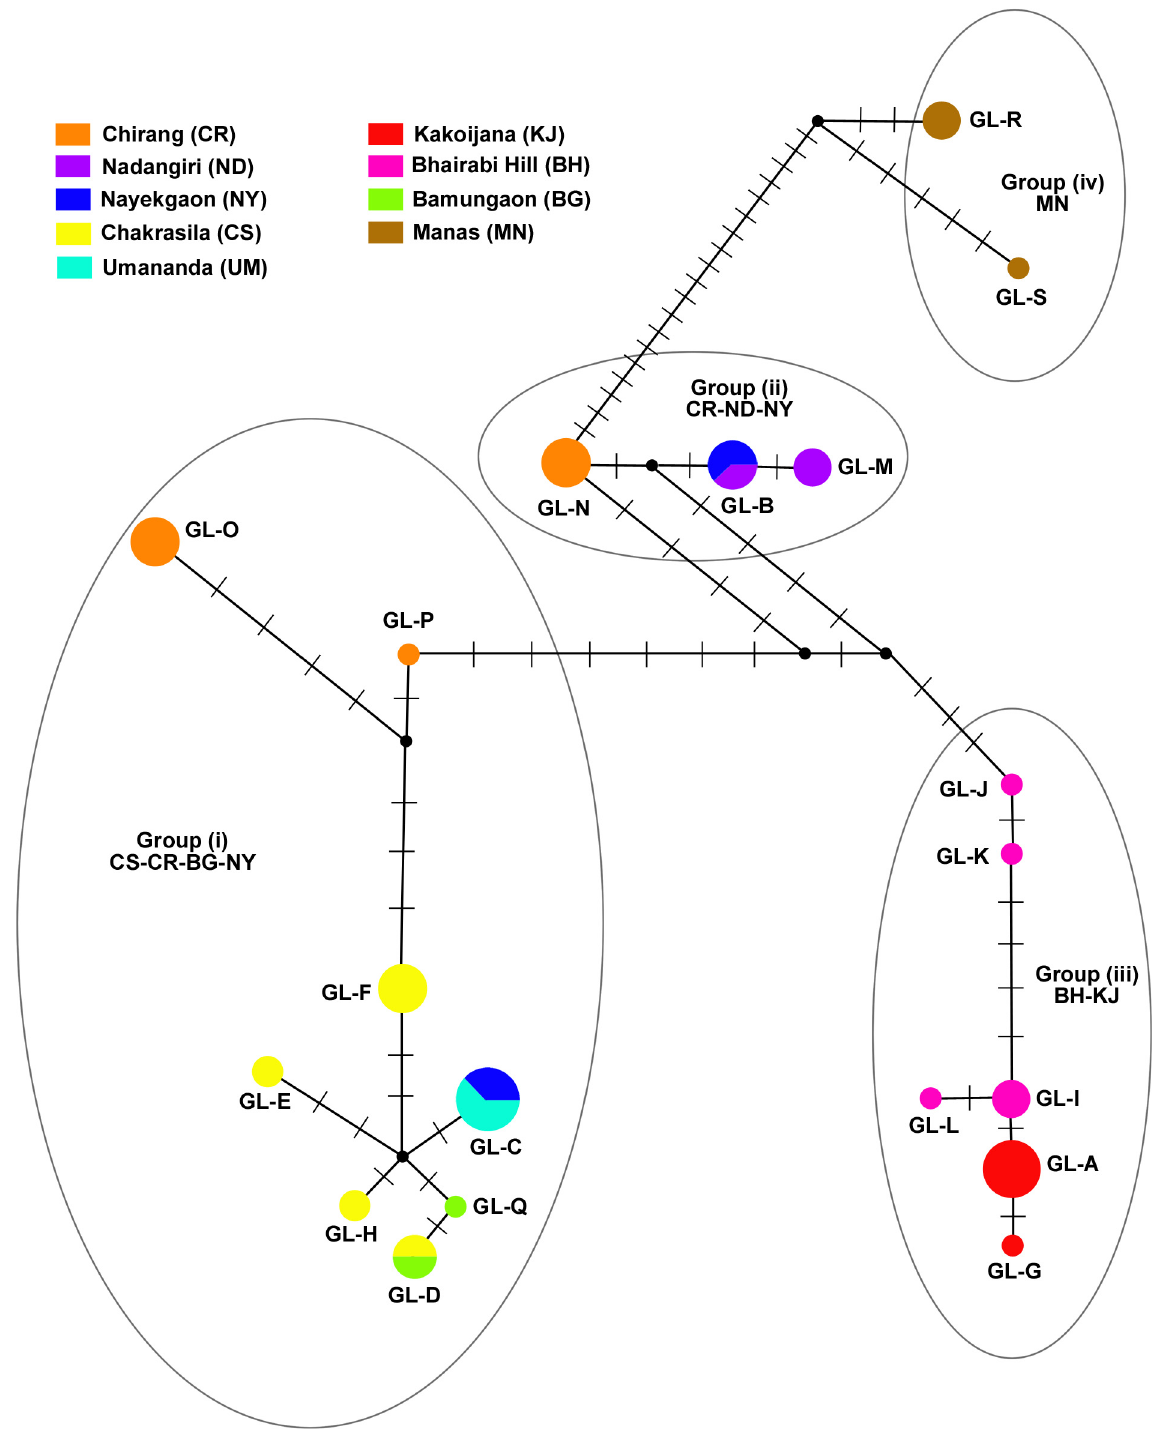
Fig 2. Median-joining network. Median-joining network of mtDNA HVRI haplotypes of golden langurs. The size of each circle represents the frequency of each haplotype (N = 59) and the colours represent each fragment. Each bar on the lines connecting two haplotypes represents one mutational